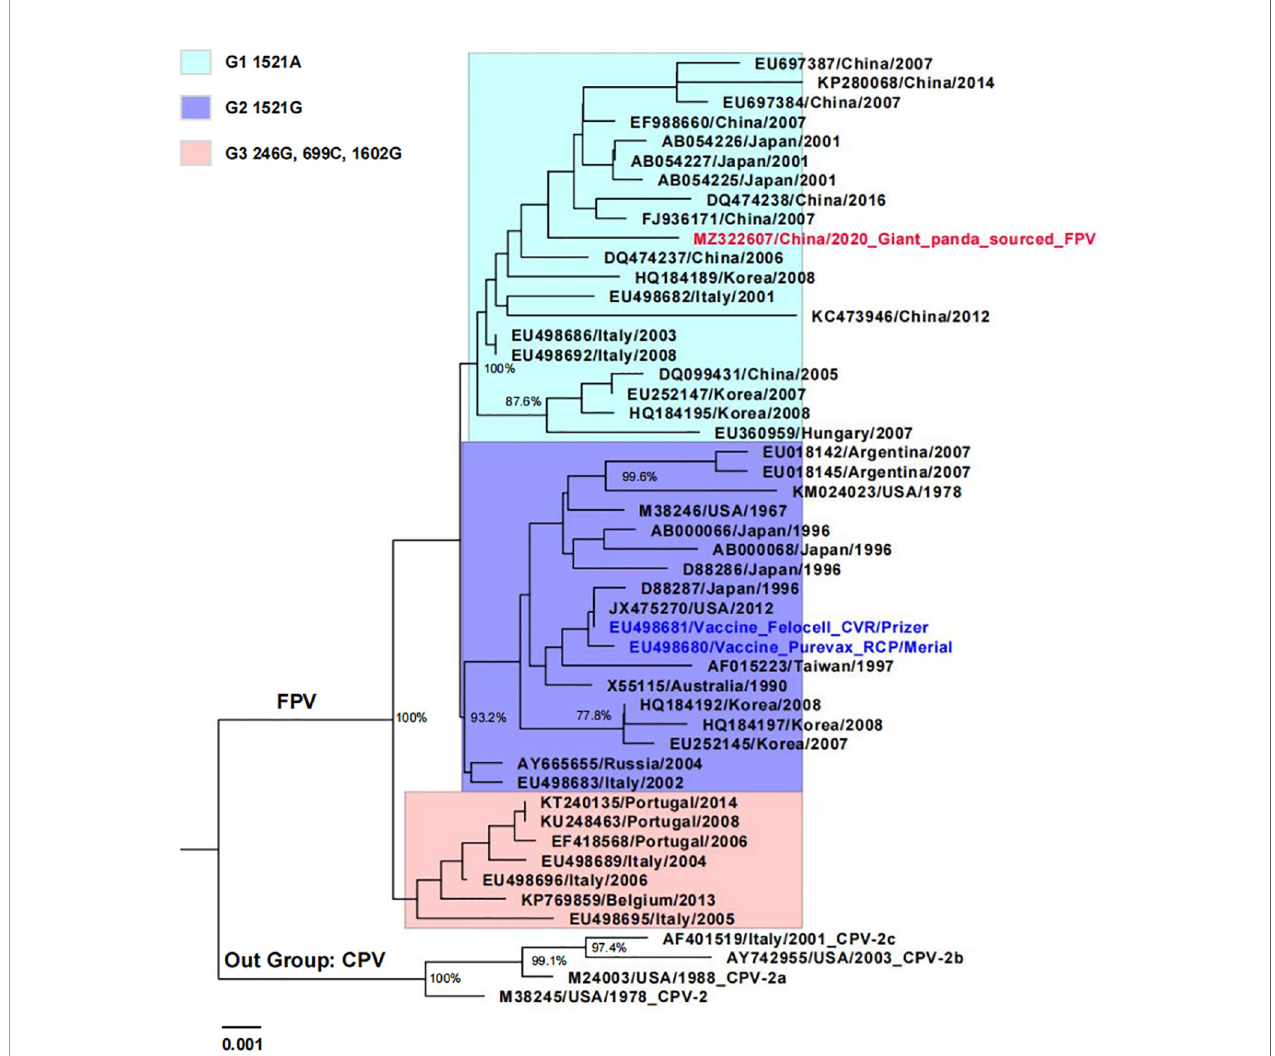
FIGURE 2 | Phylogenetic tree of giant panda-derived FPV isolate compared with other related parvovirus strains obtained from the GenBank database based on the full-length VP2 nucleotide sequences. The tree was generated using the neighbor-joining method in MEGA 7.0 with 1,000 bootstrap values and visualized using Figtree. Only bootstrap values >70% were displayed above the tree branches. Horizontal branch lengths are proportional to genetic distances. Scale bars indicate nucleotide substitutions per site. Red text indicates giant panda-sourced FPV isolated in the present study; blue text indicates FPV vaccine strain; FPV cluster 1 (G1), 2 (G2), and 3 (G3) are shown with different background